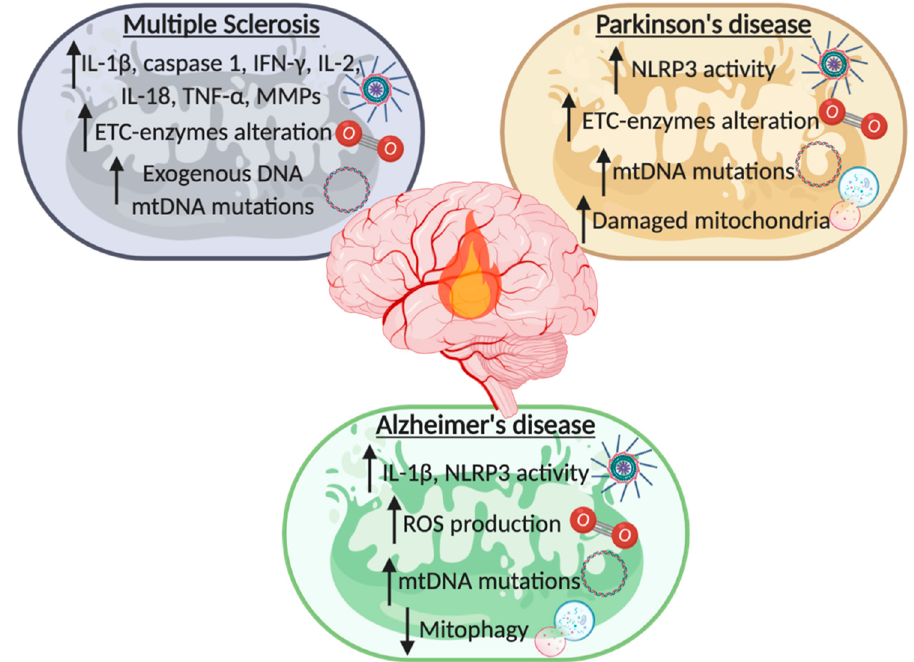
Figure 2. Schematic list of mitochondrial contribution to the recurrence of neuroinflammation during the development of neurodegenerative diseases (NDDs). In multiple sclerosis, Parkinson’s disease, and Alzheimer’s disease mitochondria have a fundamental role in the induction of a neuroinflammatory state by the activation of inflammasomes, variation of the electron transport chain (ETC) enzymes, modulation of reactive oxygen species (ROS) production, alteration of the mtDNA and of the mitophagic process. Created with BioRender.com.